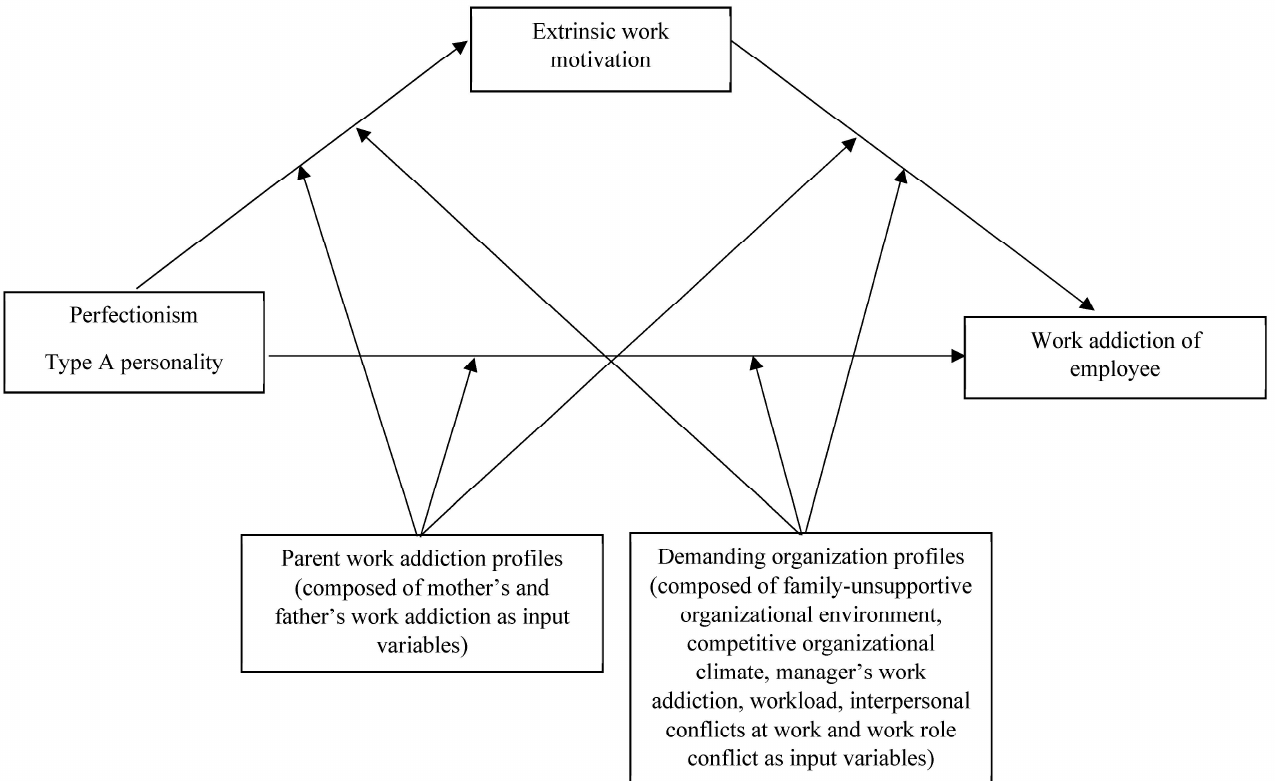
Figure 1. Theoretical moderated mediation